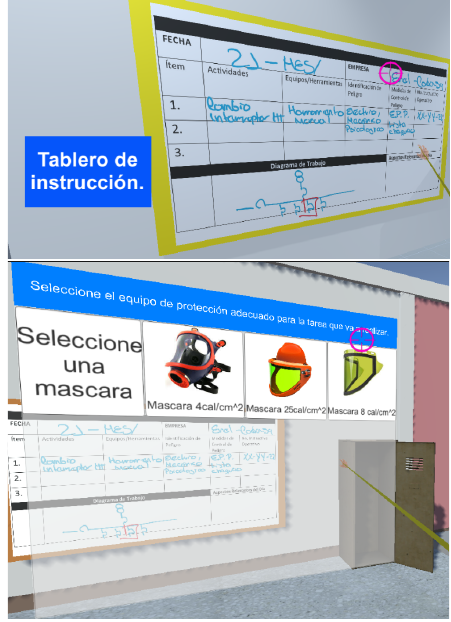
Figure 6. Interactions available on the game: top, the point-and-activate option can be seen where an interactive object changes its colour; bottom, the point and select are